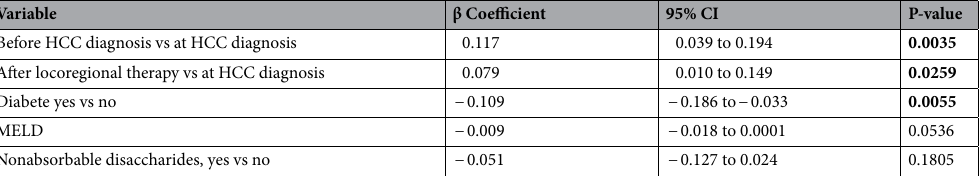
Table 3. Linear mixed-effect model of serum Mg concentration at different time points. Linear mixed effect model adjusted for furosemide and potassium-sparing diuretic administration. HCC hepatocellular carcinoma, MELD model for end-stage liver disease. p-values numbers marked in bold indicate numbers that are significant at the p < 0.05 level